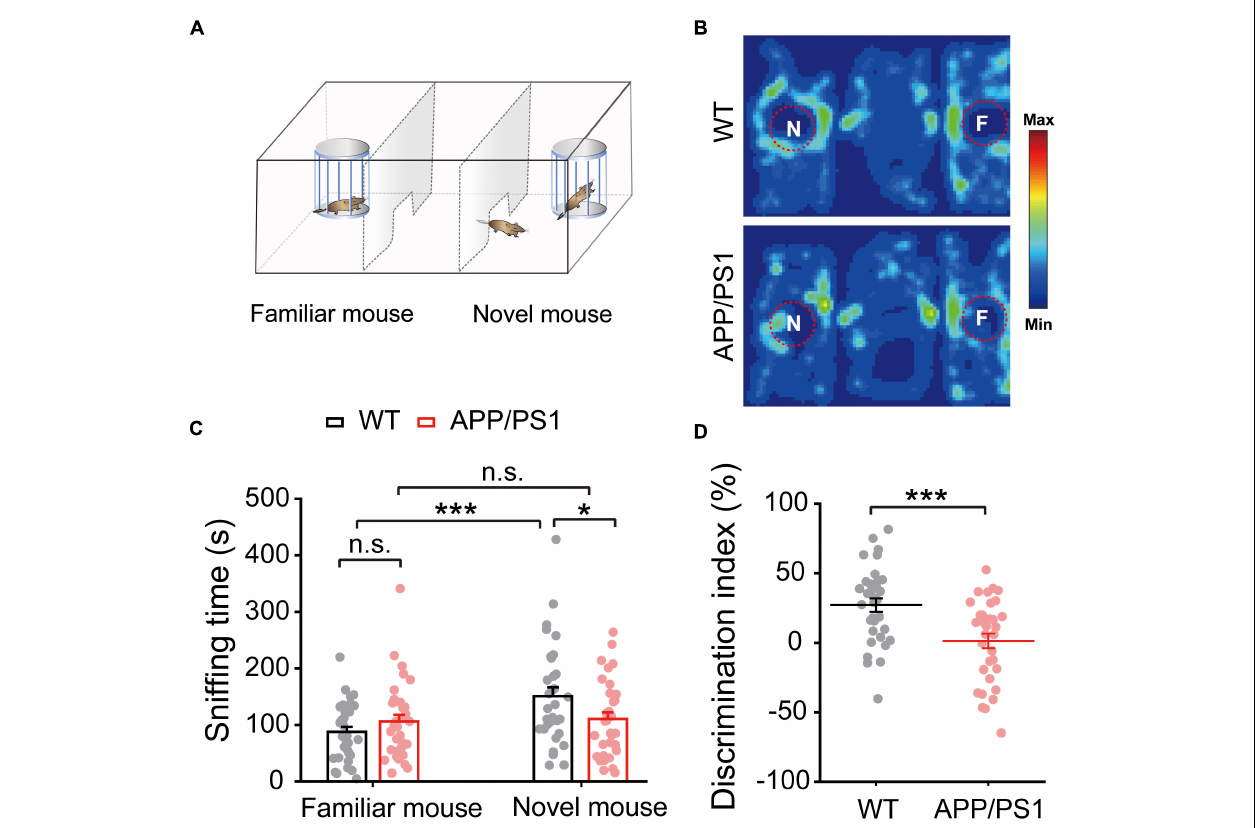
FIGURE 8 | Impaired social interaction memory in 4 ∼ 5 month-old APP/PS1 mice. (A) Schematic diagram of the three-chamber social memory test setup, showing test mouse, familiar mouse chamber, and novel mouse chamber. (B) Representative heat map of a test mouse showing mouse activity during the test phase. (C) Time spent sniffing by test mouse in proximity to novel and familiar mice, showing that APP/PS1 mice spent less time than WT mice sniffing the novel mouse. (D) Decreased discrimination index of APP/PS1 mice compared to age-matched WT mice. Values represent mean ± SEM. WT: n = 33 mice; APP/PS1: n = 33 mice; one-way ANOVA, two-sample paired t -test. Values represent the mean ± SEM, * p < 0.05, *** p <